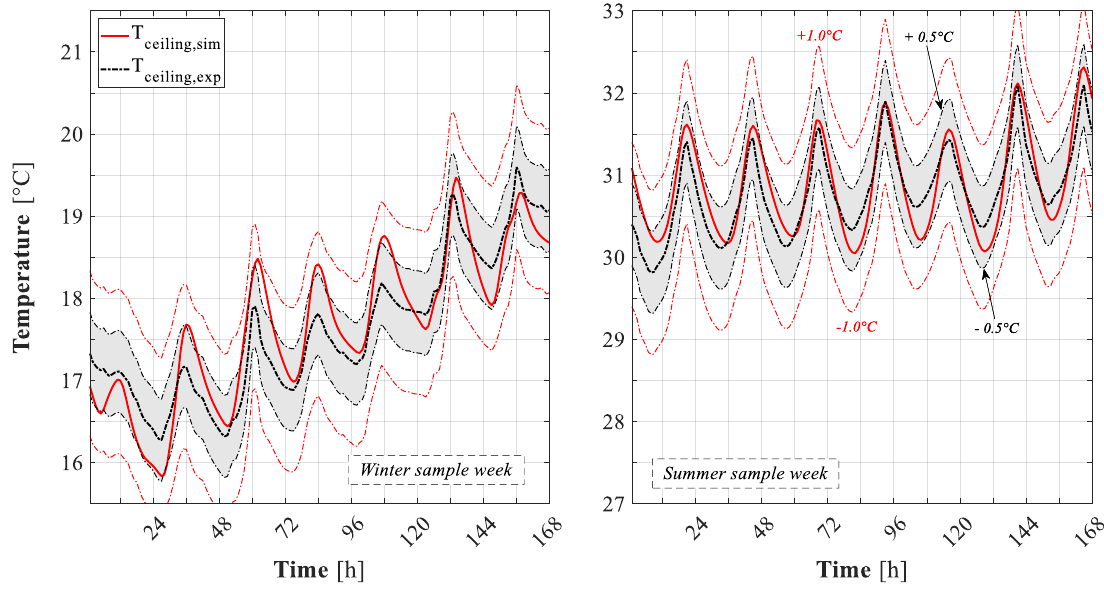
Figure 17. Ceiling temperature: simulated vs. experimental results (two sample weeks).